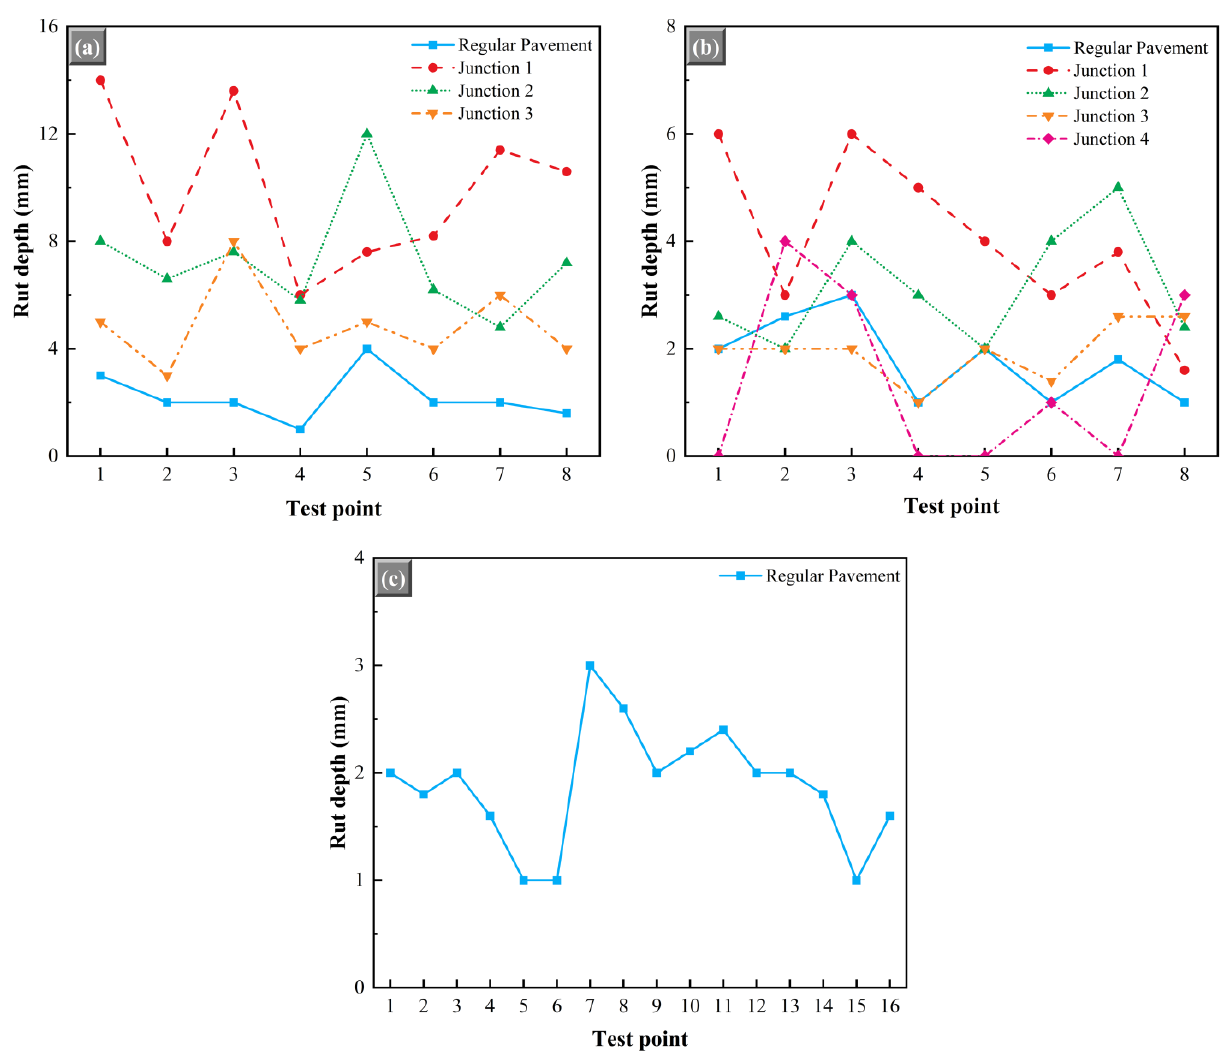
Figure 14. Test results of rutting depth: ( a ) test road 1; ( b ) test road 2; ( c ) test road 3.